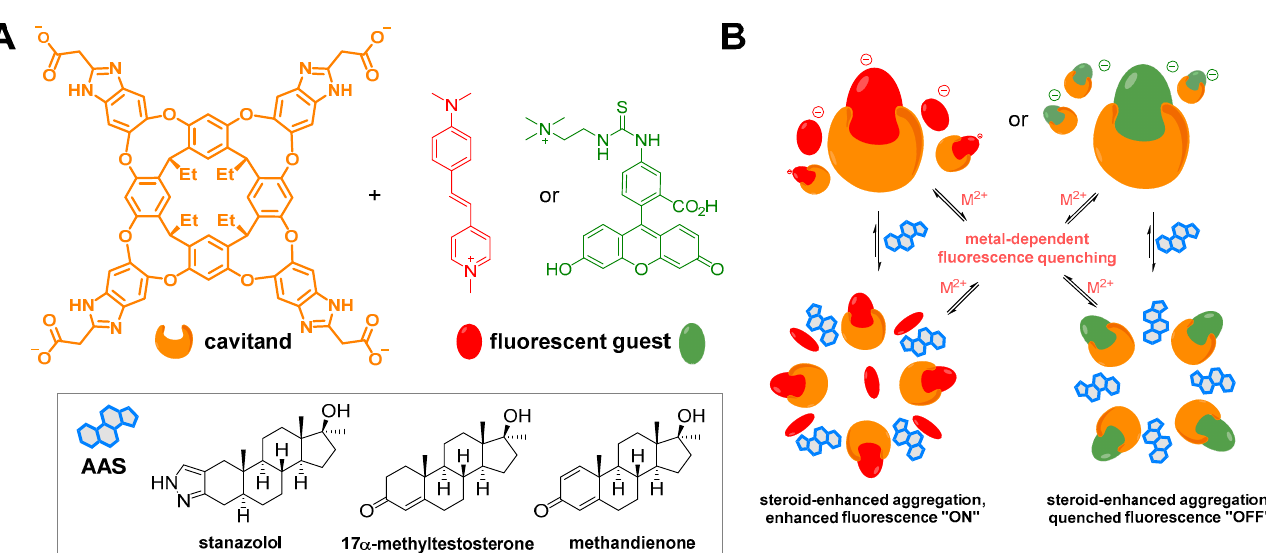
Figure 12. A diagram showing the molecular structure of the host (in orange), fluorescent guests (in red, trans -4-[4-(dimethylamino)styryl]-1-methylpyridinium iodide (DSMI), and a fluorescein-based dye in green), and tested anabolic-androgenic steroids (AASs; ( A )). Possible aggregation modes of the complexes and the effects of steroid addition on the emission profiles ( B ). The sensing is triggered by an aggregation mechanism. Aggregation can be mediated by the presence of both metal ions and steroids. Both the “turn-on” and “turn-off” modes of fluorophores are essential for analyte discrimination [127].